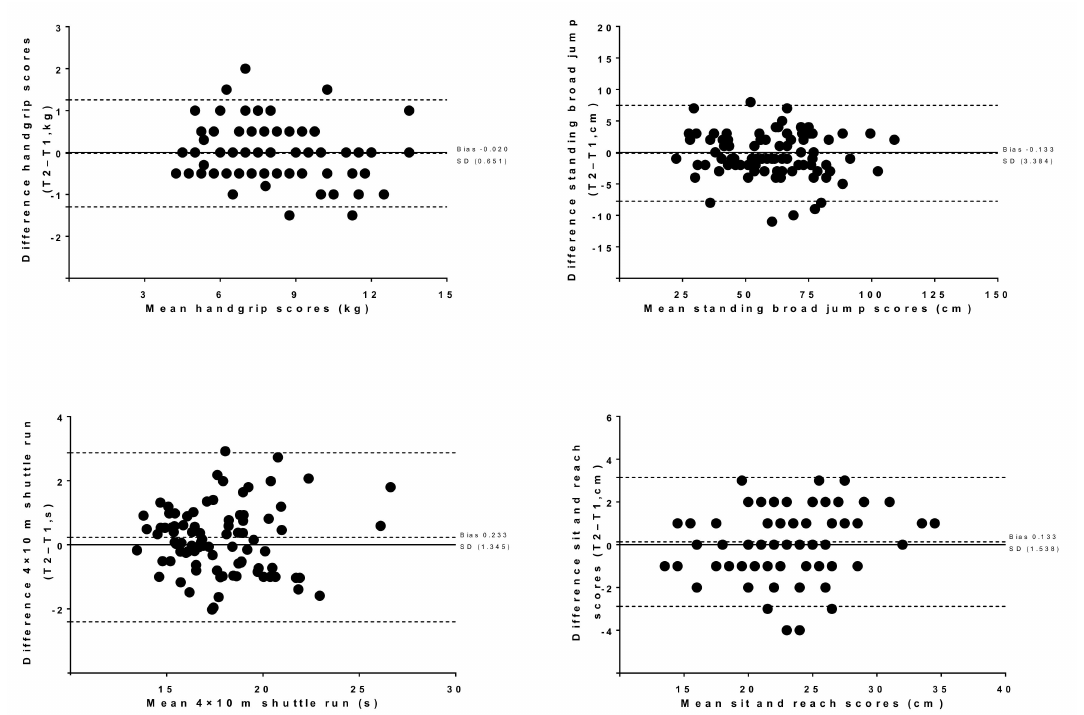
Figure 1. Bland–Altman plot of the “Fuprecol kids” battery (preschool children fitness testing) 20 m shuttle run test (laps and stage), handgrip strength, standing broad jump, 4 × 10 m shuttle run test, and sit and reach test among Colombian preschool children: The “Fuprecol kids” study. The central dotted line represents the mean di ff erences between the second trial (T2) and the first trial (T1); the upper and lower dotted lines represent the upper and lower 95% limits of agreement (mean di ff erences ± 1.96 SD of the di ff erences),